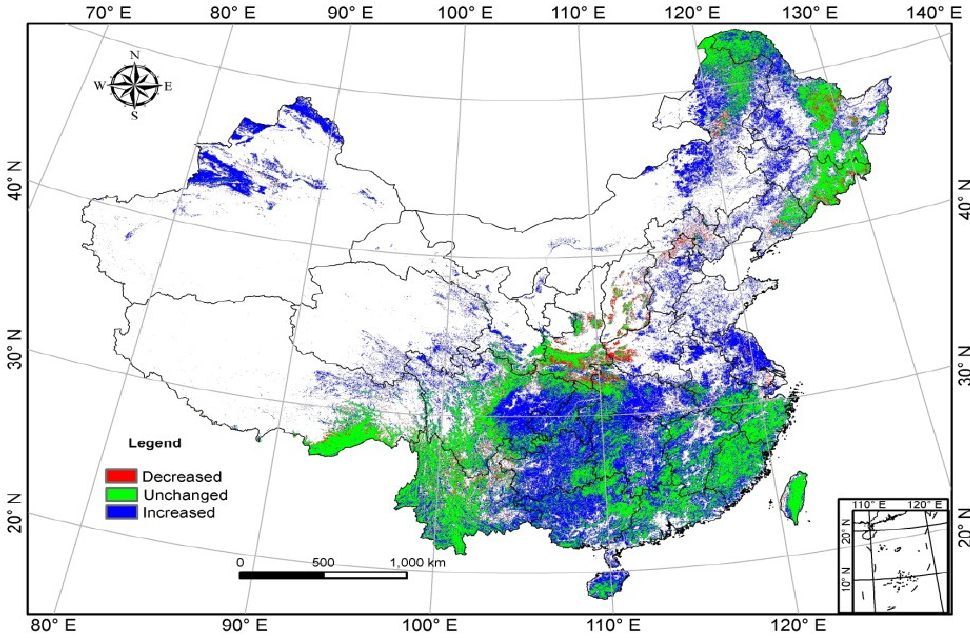
Figure 4. Forest distribution of China in 2001. Green (Unchanged) indicates that both data sets classify this land as forest. Blue (Increased) indicates that the area is classified as forest in the histogram results but not in MODIS. Red (Decreased) indicates that the area is classified as forest in the MODIS landcover data but not in the histogram results.